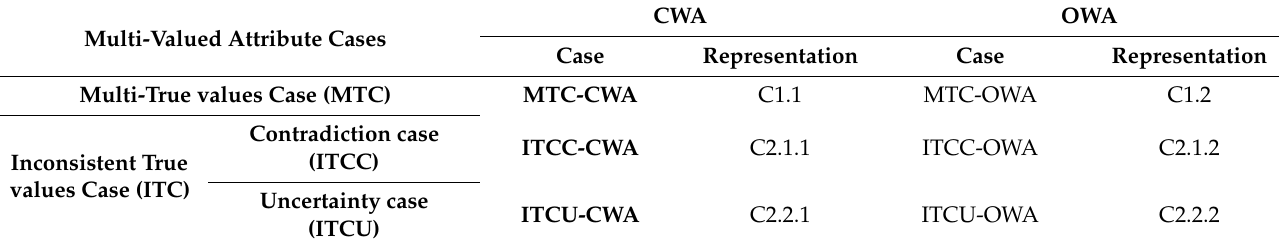
Table 1. The data fusion cases are based on the CWA or the OWA